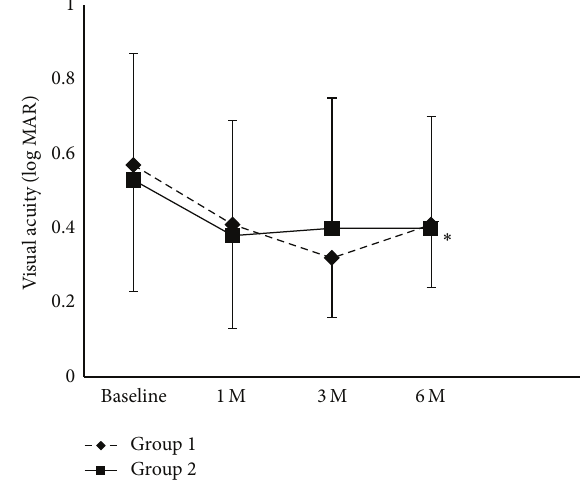
Figure 1: Best corrected visual acuity in logMAR for both eyes of Group 1 and Group 2. Notes: ∗ 𝑃 < 0.05 , compared with the respective baseline value (just before the second intravitreal bevacizumab